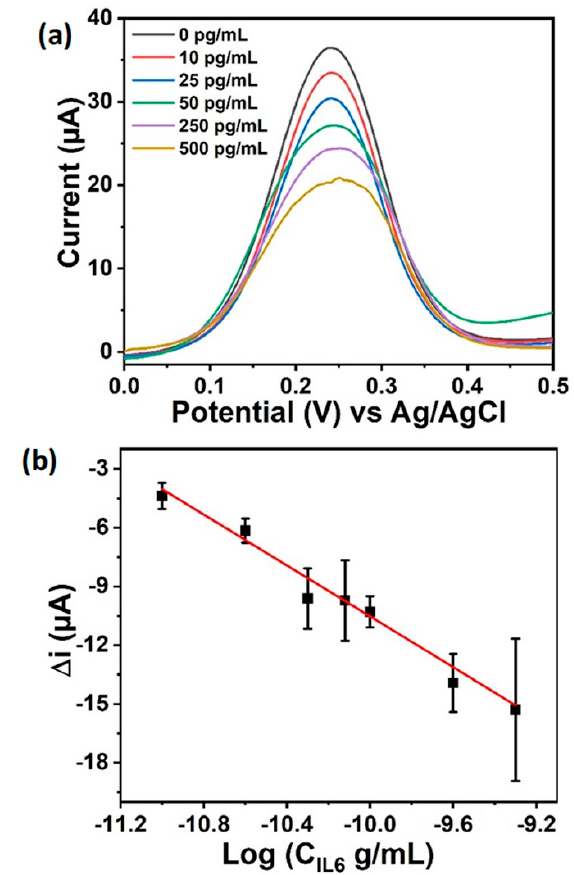
Figure 3. ( a ) DPV curves of graphitic carbon (GC) biosensor at varying concentrations of IL-6 con-